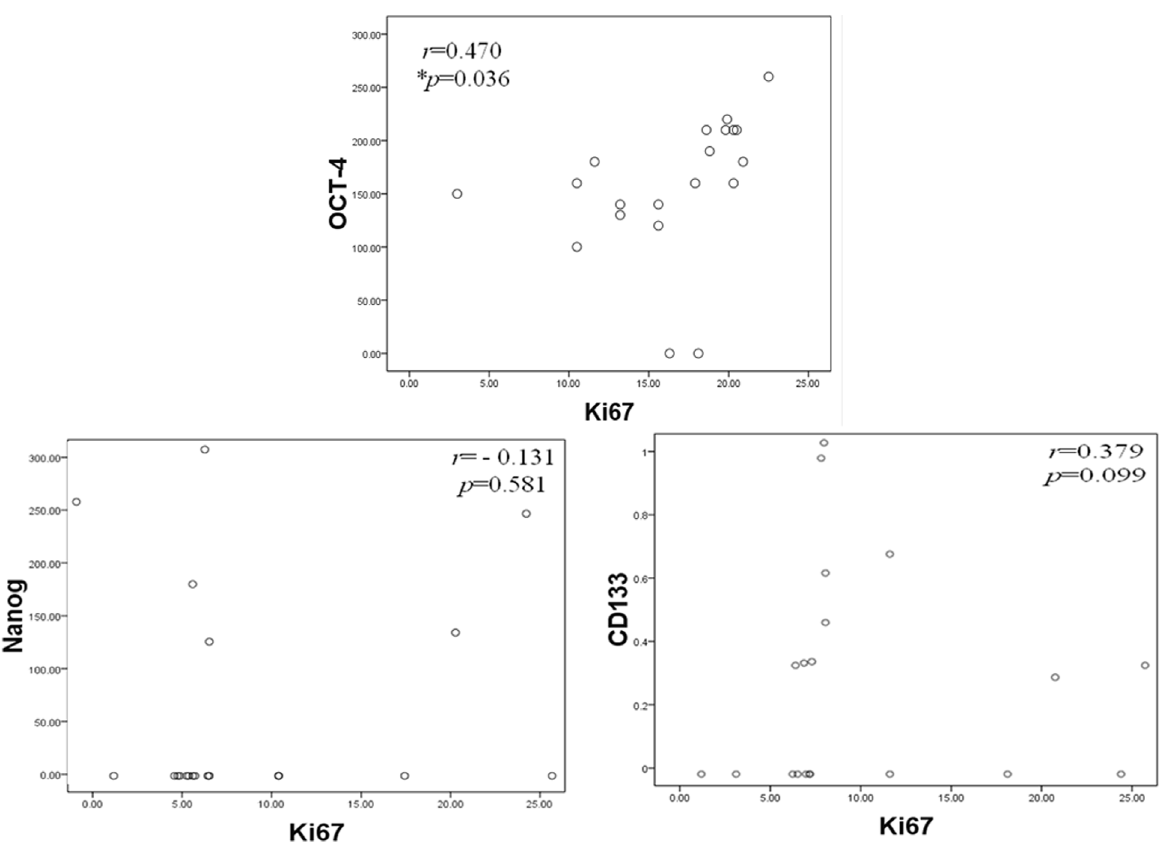
Figure 4. Correlation of immunoexpression of CSC-representative markers with Ki67. Comparative analysis using linear regression test of CSC-representative markers (Nanog, OCT-4, and CD133) with Ki67 showed that only OCT-4 was found positively correlated with Ki67. However, there were no correlations at all between the expressions of Nanog and CD133 and Ki67.